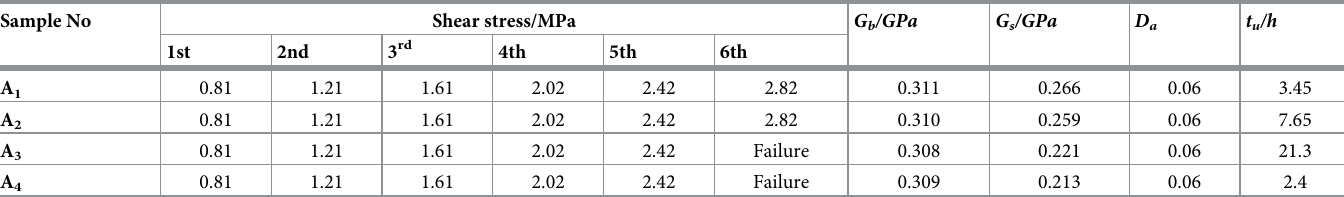
Table 1. Related test parameters of